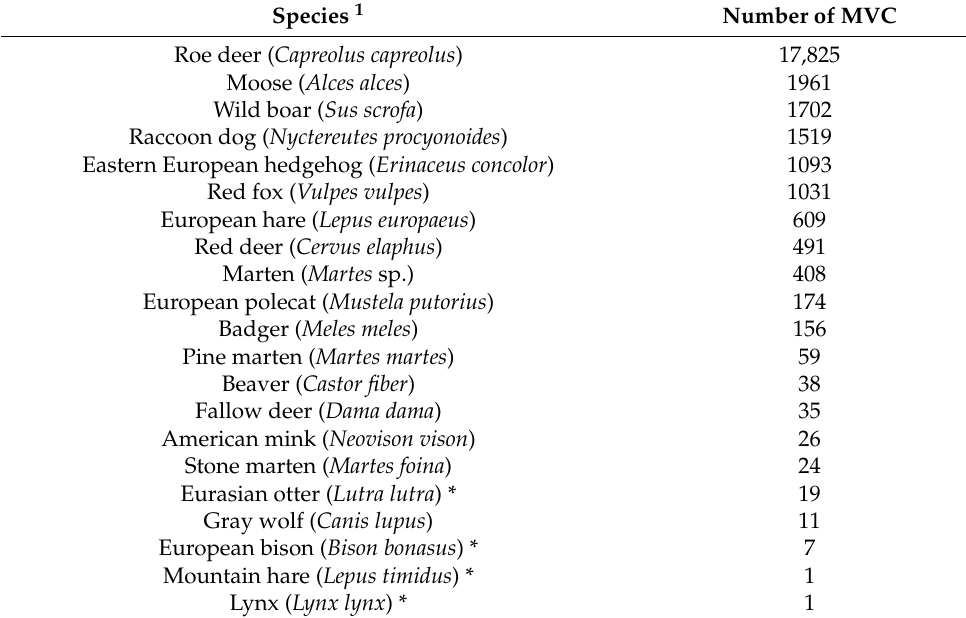
Table 1. The number of mammal–vehicle collisions in Lithuania, registered in 2002–2020. Species included in the national Red data list are marked with an